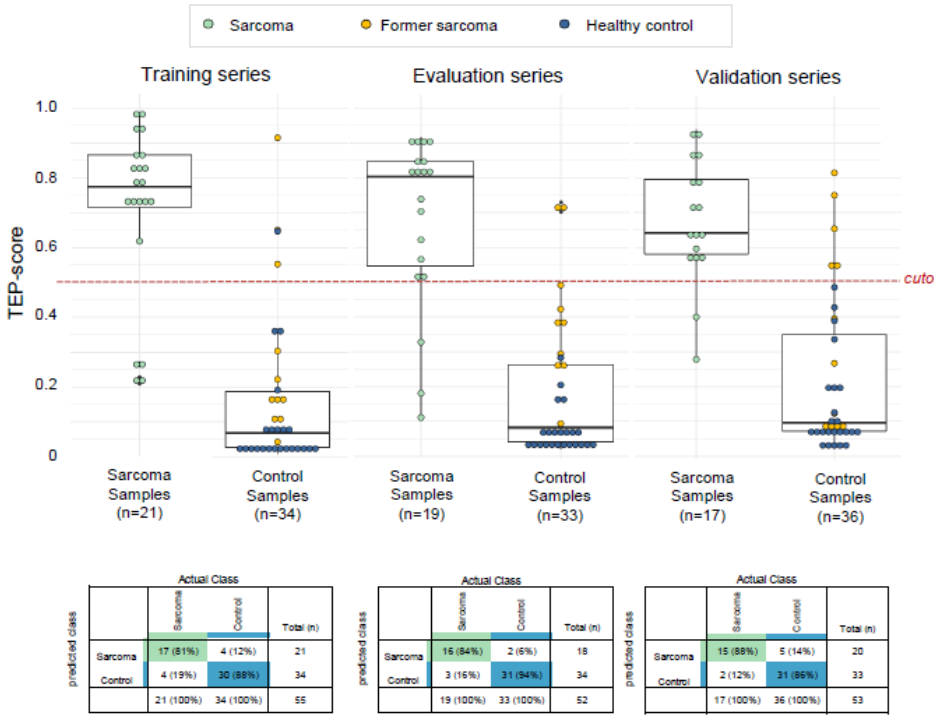
Figure 2. Distribution of the tumor-educated platelets (TEP)-score for the training, evaluation and validation series. The distribution of the TEP-score for the training, evaluation and validation series for both discriminative groups, patients with sarcoma and controls. Samples are colored by their cancer status. In green, patients with present sarcoma tumor load, in blue, healthy donors without any history of cancer, in yellow, samples obtained from former sarcoma patients who are currently monitored for disease recurrence. Below are per series shown 2 × 2 cross-tables, indicated are sample numbers and detection rates in percentages.